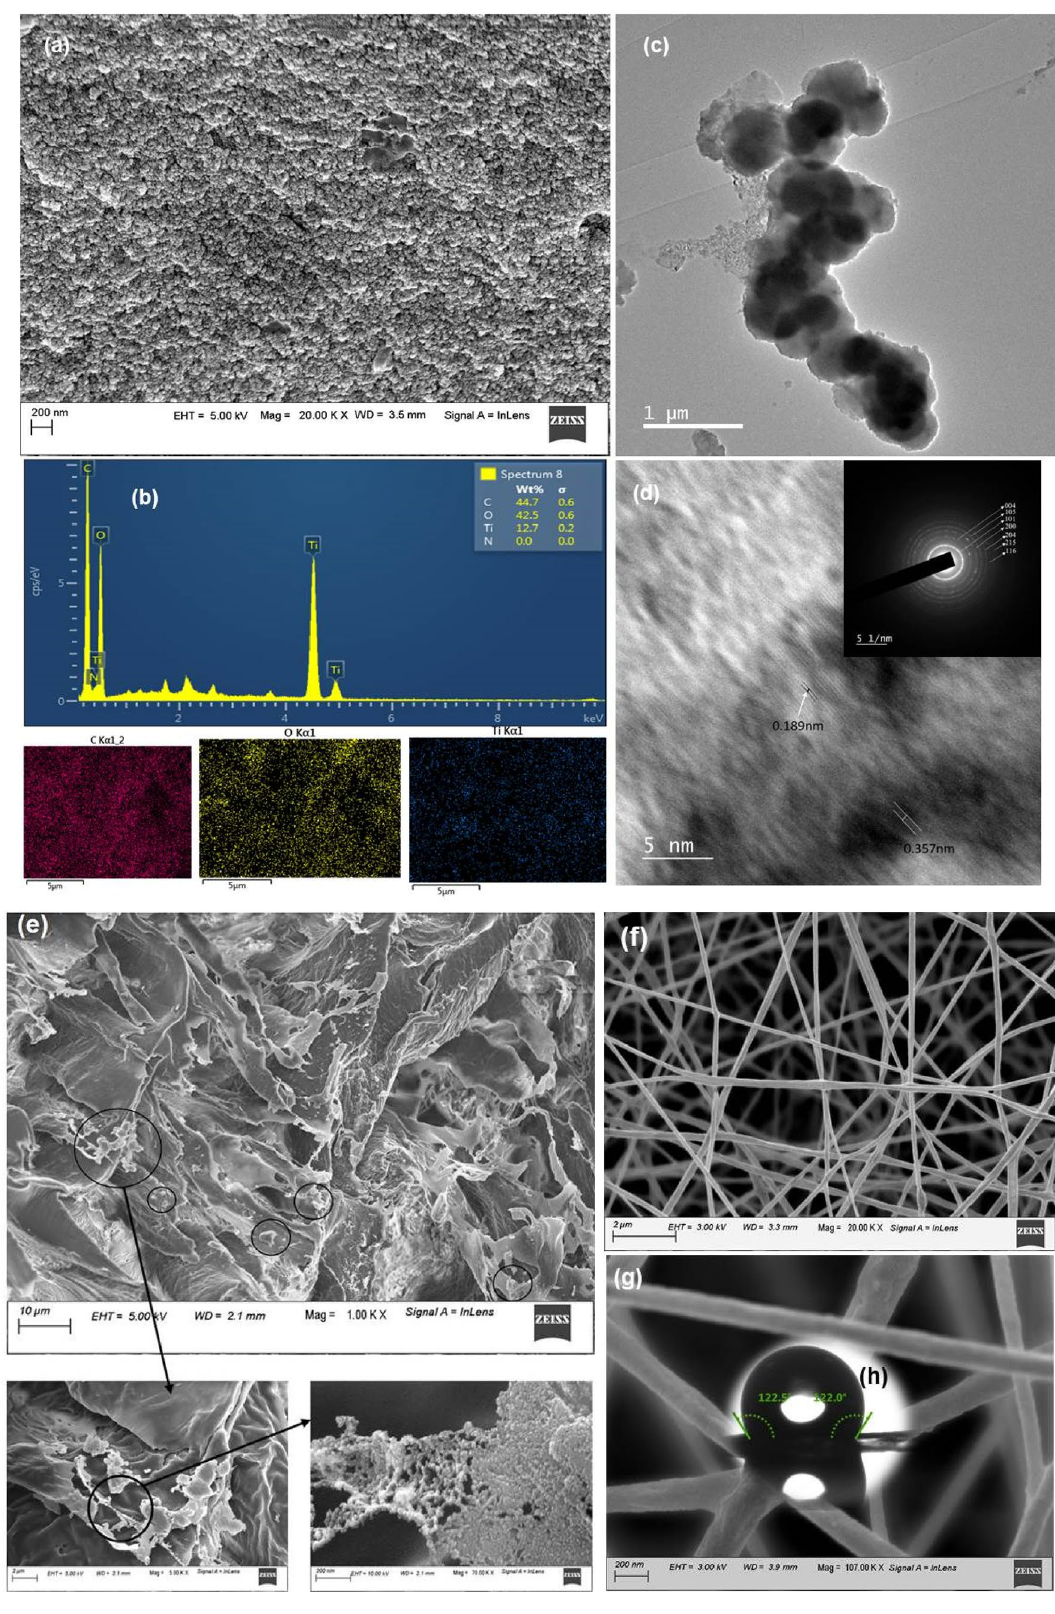
Figure 5. ( a ) FESEM micrograph showing SNC nanoparticles, ( b ) EDX analysis of ana-TCS (inset: mapping for Ti, O, N content with wt. % composition), ( c ) FETEM micrograph of the fabricated ana-TCS, ( d ) HRTEM image elaborating the d- spacing corresponding to the anatase form of TiO 2 (inset: SAED pattern showing anatase TiO 2 over SNC template), ( e ) FESEM micrographs of the PLLA/ ana-TCS nanocomposite showing the distribution of ana-TCS with network formation of TiO 2 over SNC nanoparticles in a magnified way, ( f ) PLA/ana-TCS electrospun fiber, ( g ) magnified smooth surface of the electrospun fabric, ( h ) WCA of the nanofabric material depicting surface